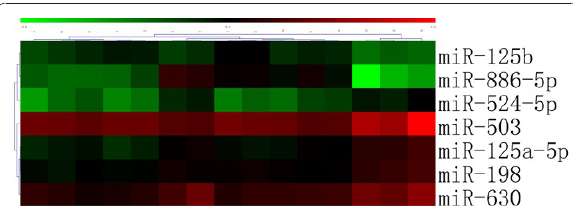
pituitary adenomas . SSA Responders:1-12, SSA